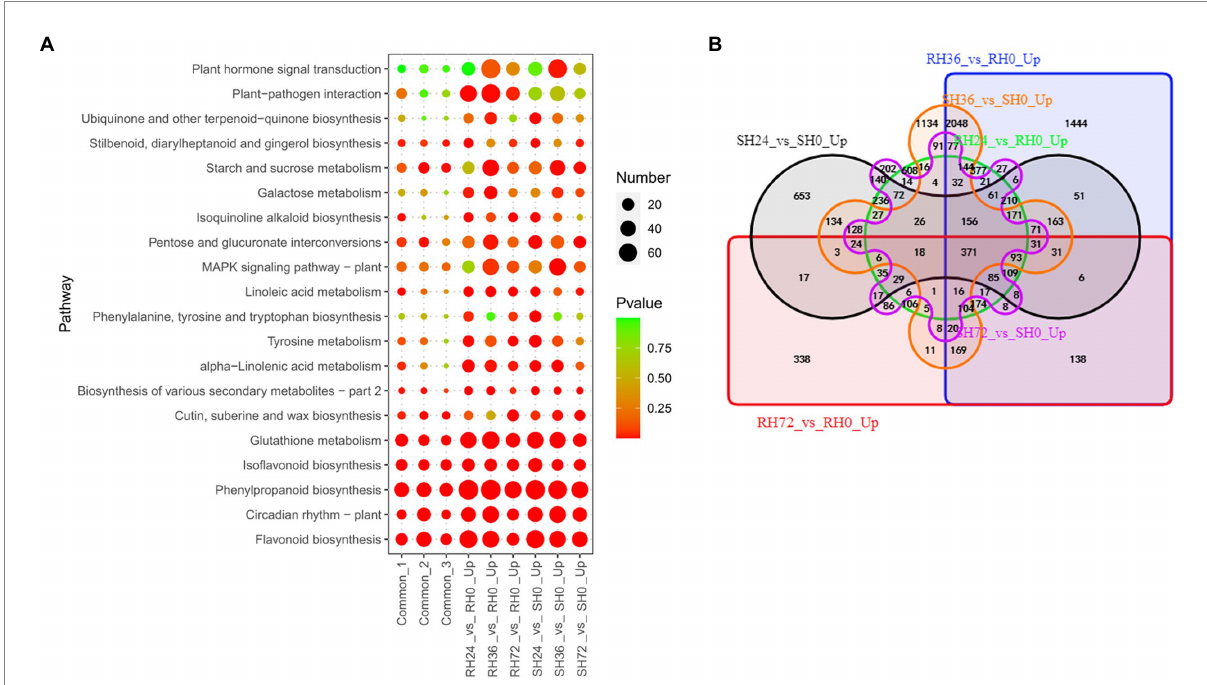
FIGURE 5 Identification of PAMPs induced resistance-response DEGs in RH24 vs. RH0, RH36 vs. RH0, RH72 vs. RH0, SH24 vs. SH0, SH36 vs. SH0, and SH72 vs. SH0. (A) KEGG enrichment analysis of common and up-regulated DEGs in each comparison group. Common-1 indicates the common up- regulated DEGs in RH24 vs. RH0, RH36 vs. RH0, and RH72 vs. RH0. Common-2 is the common up-regulated DEGs in SH24 vs. SH0, SH36 vs. SH0, and SH72 vs. SH0. Common-3 is the common up-regulated DEGs between RHs vs. RH0 and SHs vs. SH0. (B) A big Venn diagram of DEGs for up-regulated DEGs between RHs vs. RH0 and SHs vs.